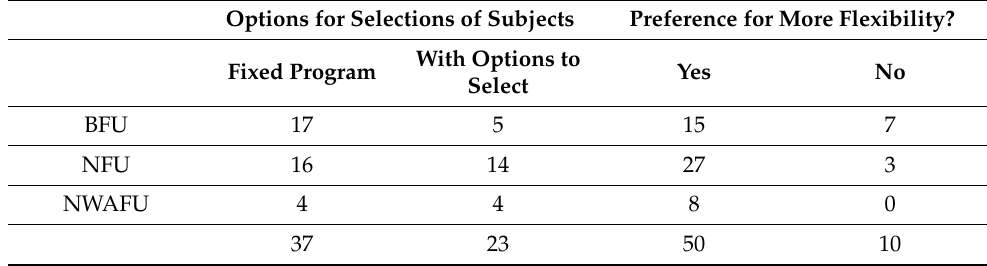
Table 2. Responses to questions regarding options and preference for more flexibility in choices of subjects in curricula.